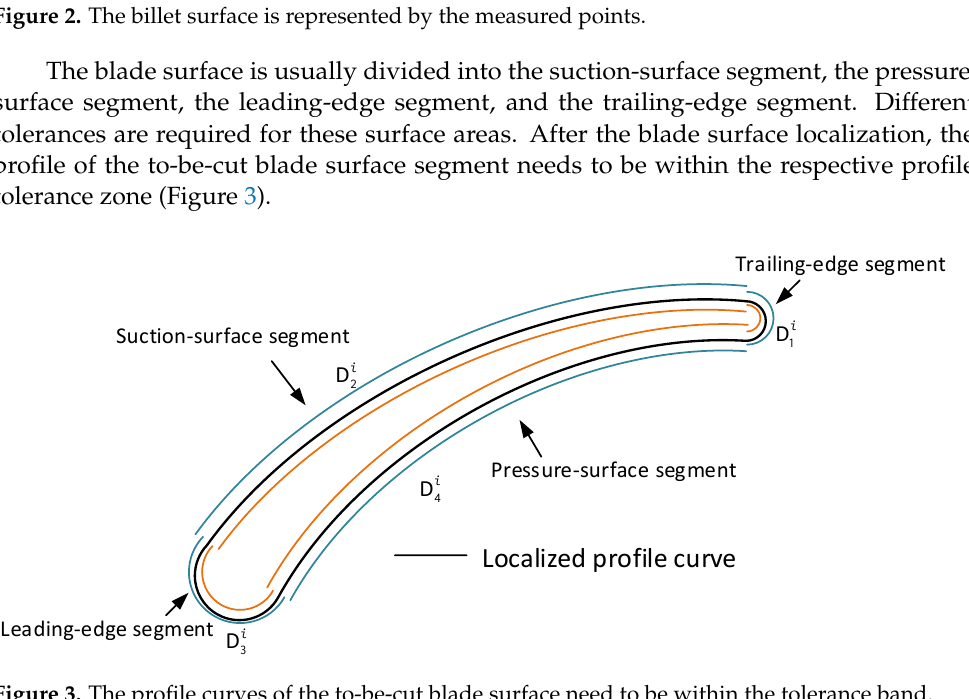
i d are the distances from the measured points to the closest points on the to-be- cut blade surface.